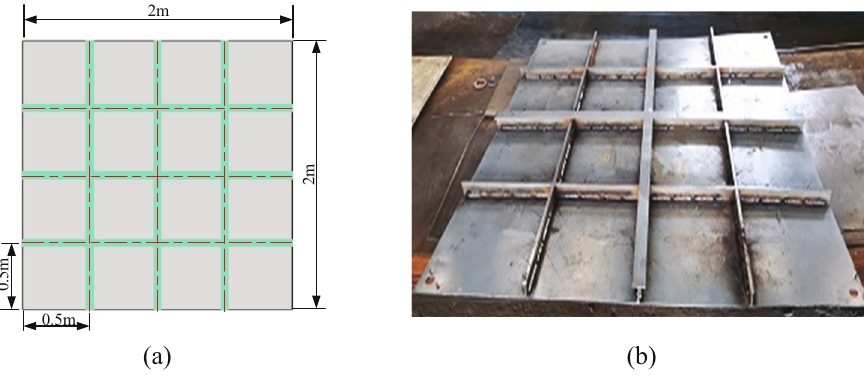
Figure 1: Test model: ( a ) diagram of test model; ( b ) physical drawing of